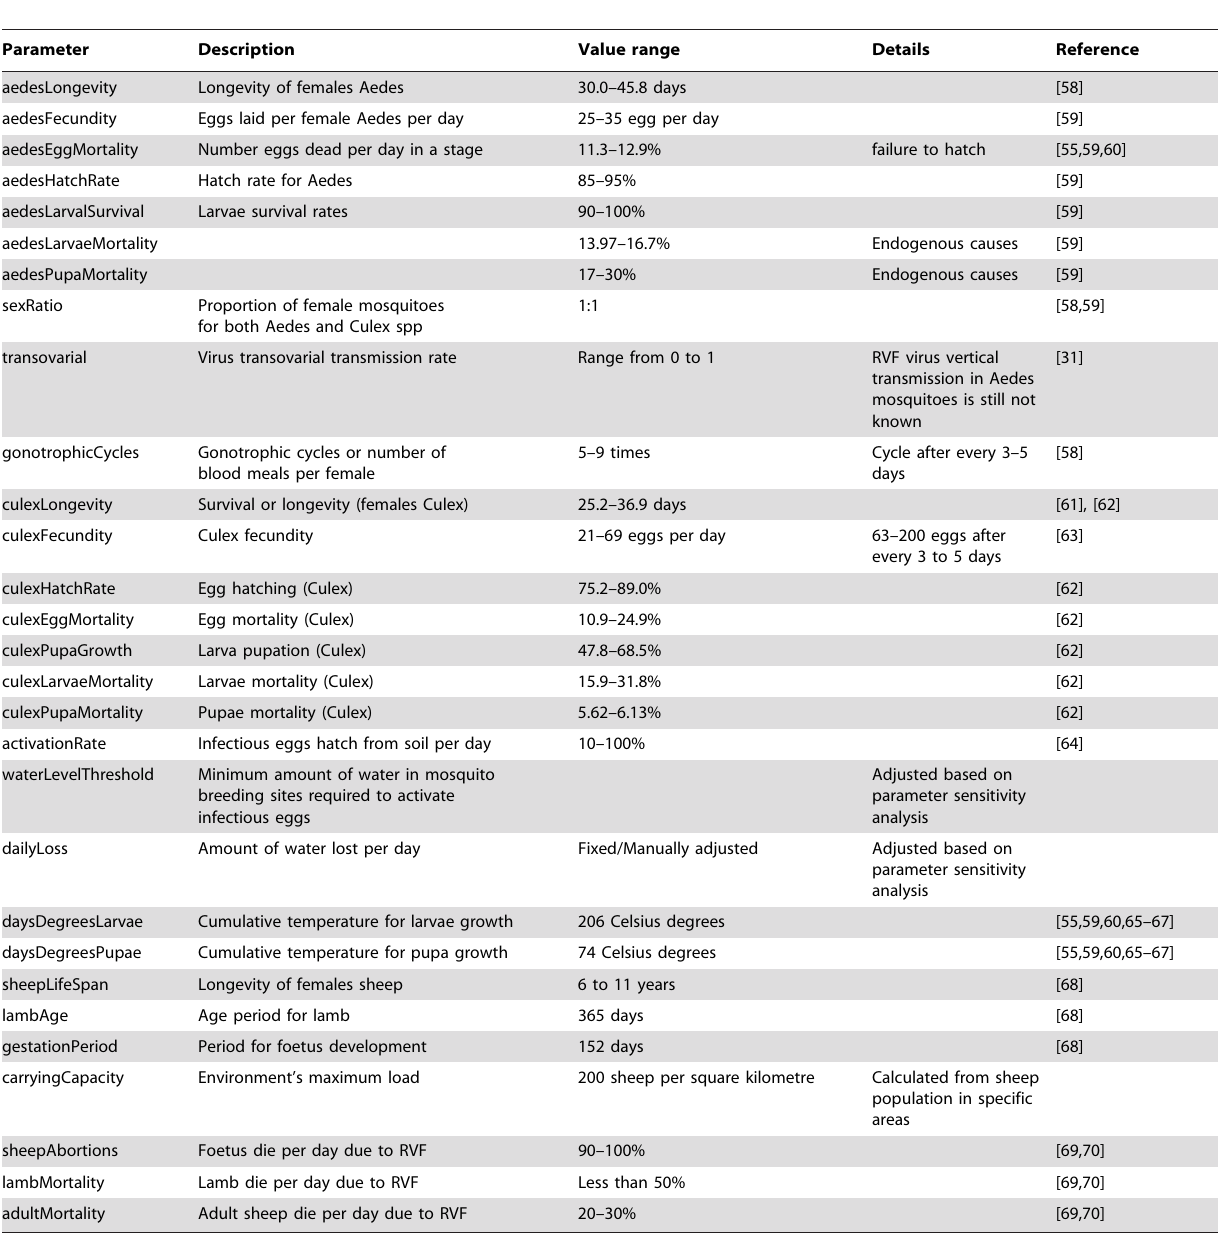
Table 1. Parameters